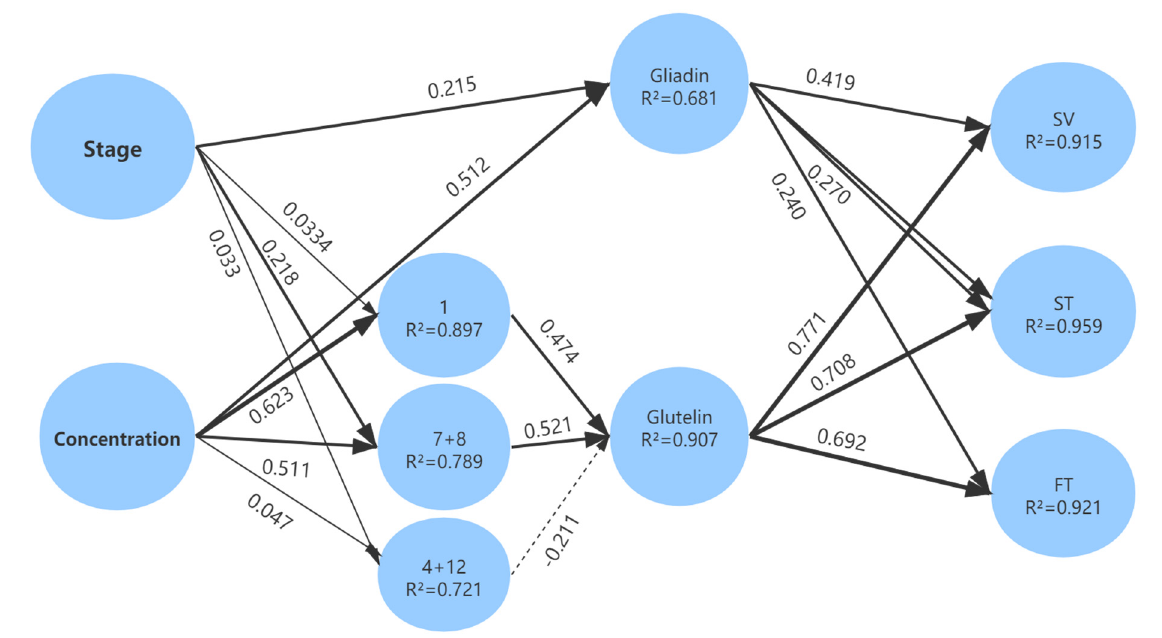
Figure 9. The results of PLS-PM showed the direct and indirect effects of period and concentration of potash application, Gliadin, Glutelin, and HMW-GS (1, 7 + 8, 4 + 12) on the process quality index (sedimentation value (SV), stabilization time (ST), formation time (FT)) of wheat XN20. Solid and dotted arrows represent the positive and negative relationships, respectively. The strength of path coefficients is proportional to the width of arrows. The variance of the explained proportion is expressed in terms of R 2 .